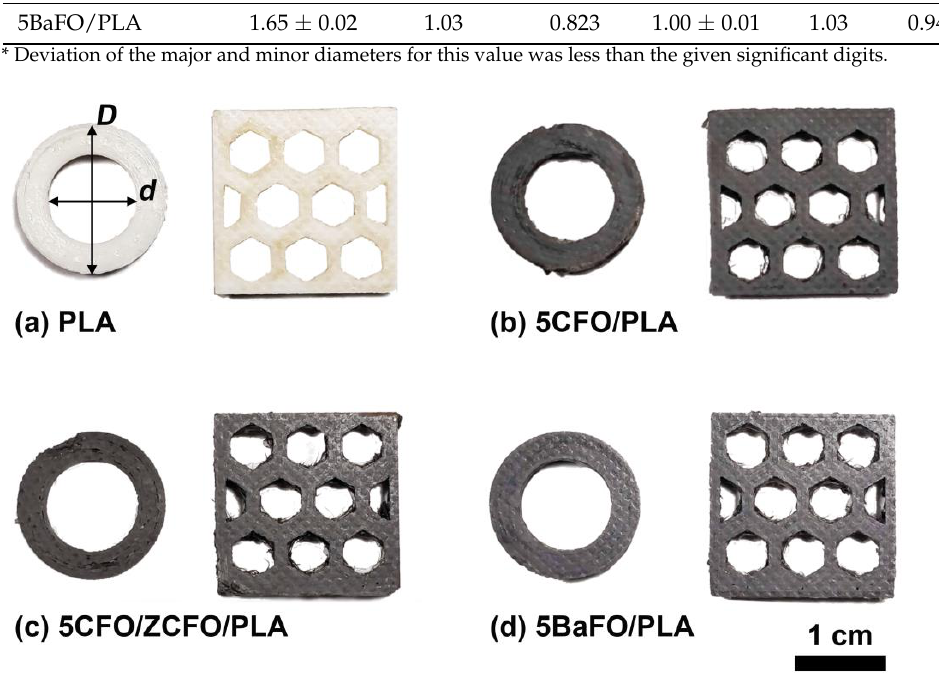
Table 3. Geometrical parameters of printed rings: D and d are the diameters of the outer and inner circles, AR is the aspect ratio, and c is the circularity index. Outer Circle Inner Circle Sample D , cm AR